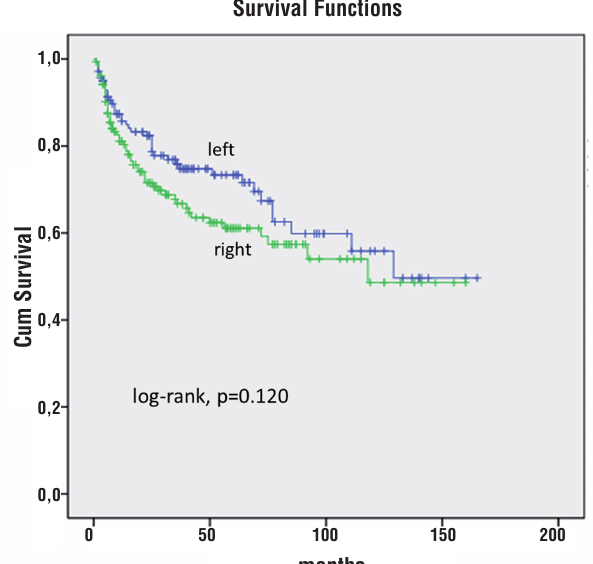
figure 4 - Kaplan-Meier product limit analysis shows time to psA biochemical progression-free outcome by index tumor left vs right predominant location. cum,